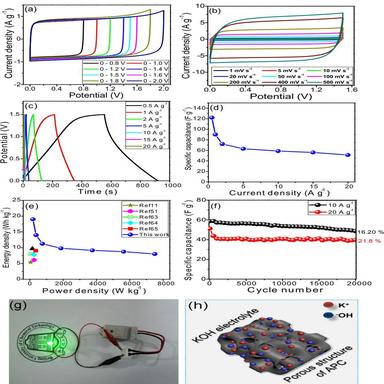
Electrochemical performance of APC electrode based coin-like symmetrical supercapacitor: (a) CV curves in the different potential widows from 0.8 to 2.0 V, (b) CV curves in the potential widow of 1.5 V at different scan rates, (c) GCD curves in the potential widow of 1.5 V at different CDs, (d) the observed SC at different CDs, (e) Ragone plots of APC electrode based supercapacitor and compared with reported porous carbon for supercapacitors, (f) cyclic stability test at CDs of 10 and 20Ag1 , (g) picture of